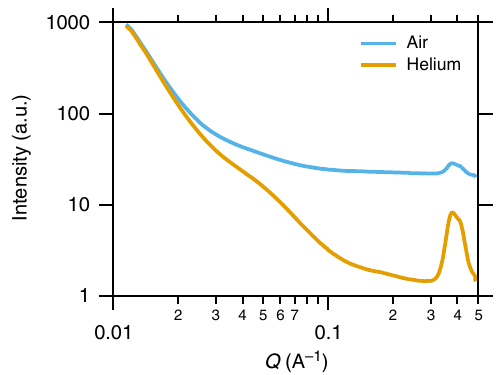
Fig. 3 Comparison of the raw SAXS signal of pure air and helium measured at ELETTRA. The background for helium is lower due to its lower electron density. In the low q -limit the scattering of the conductive Kapton is prevailing. In the intermediate and high q -range the signal from helium is about one order of magnitude lower than that of air. Thus, in the high q -range the Kapton peak is much more pronounced with